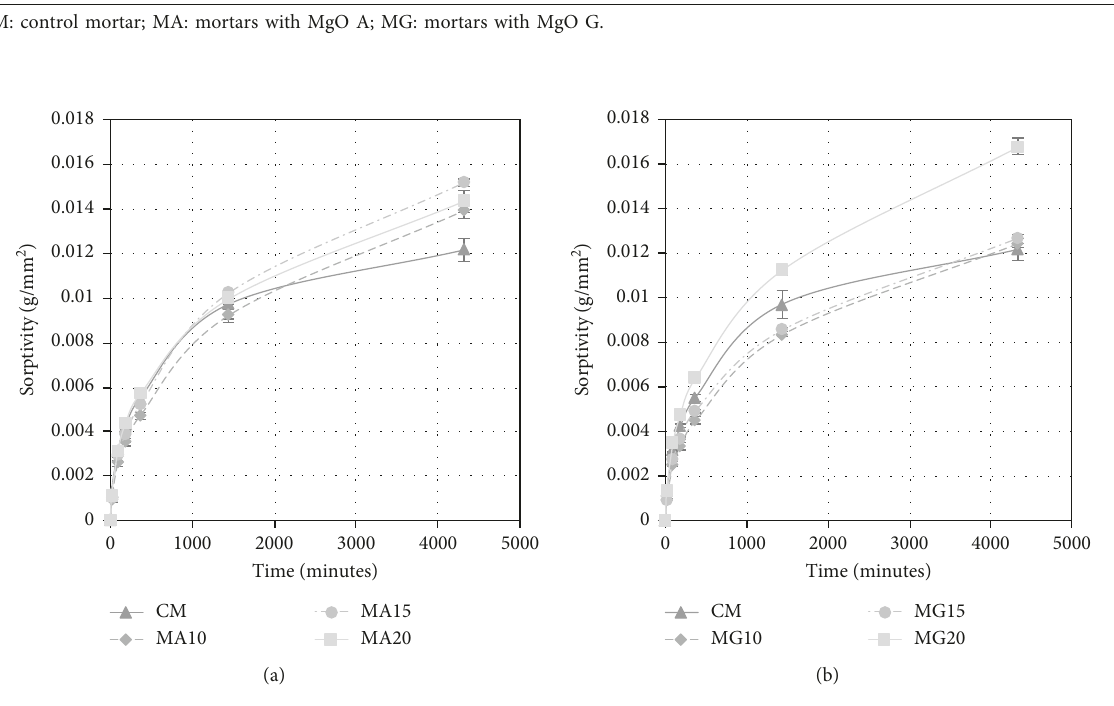
Figure 8: Water absorption by capillary action of mortars with (a) MgO A (MA) and (b) MgO G (MG).